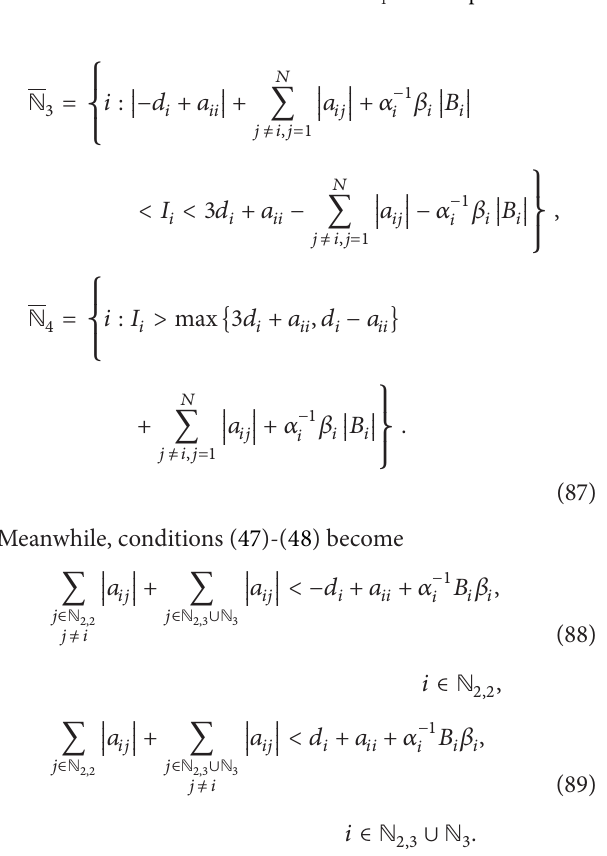
Figure 2: Transient behavior of 𝑥 1 in Example